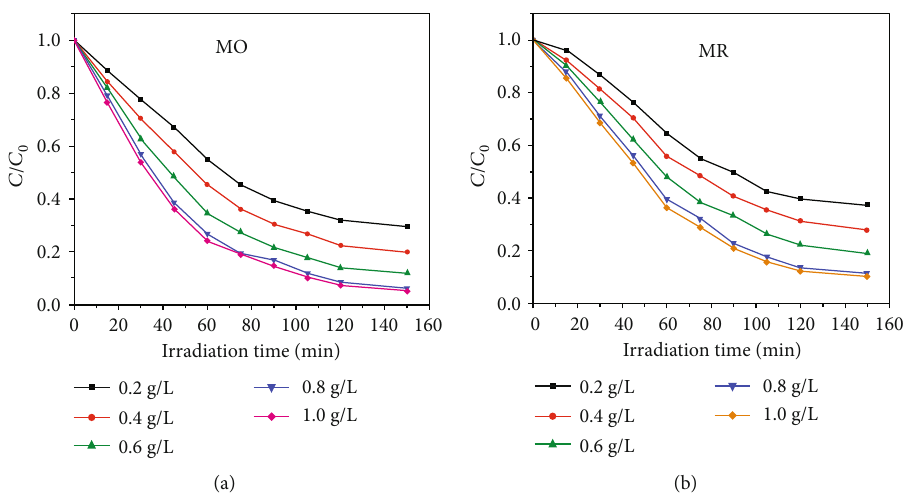
Figure 12: E ff ect of variation in dosage of photocatalyst on degradation of (a) MO and (b) MB.